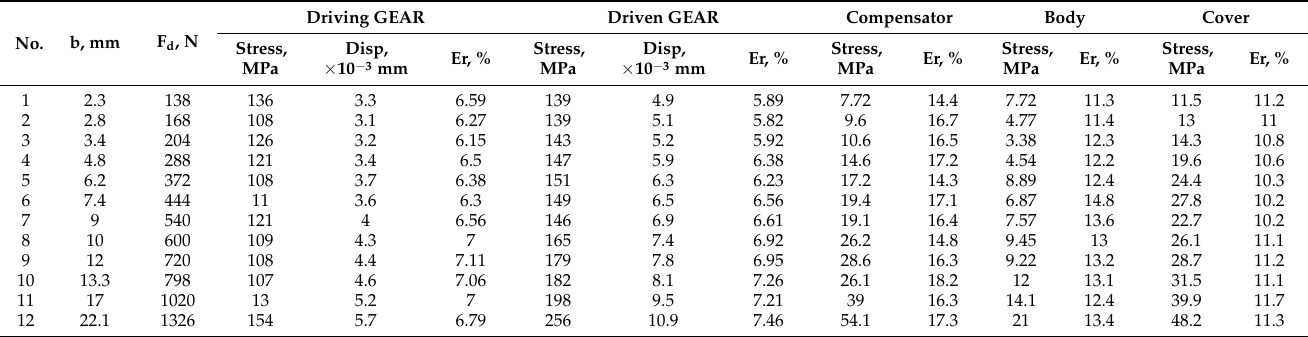
Table 3. Variation of maximum stresses, deformations and error rates.